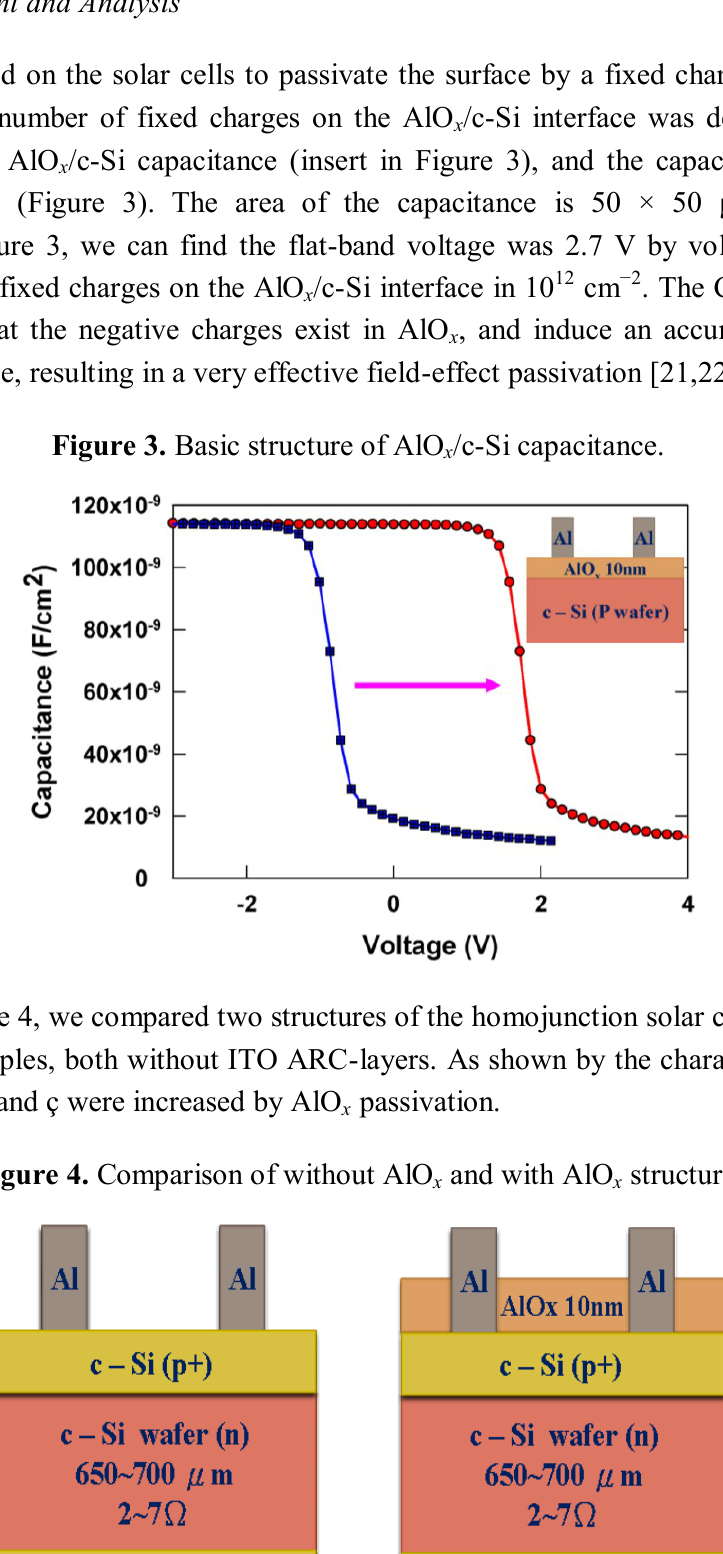
Figure 3. Basic structure of AlO